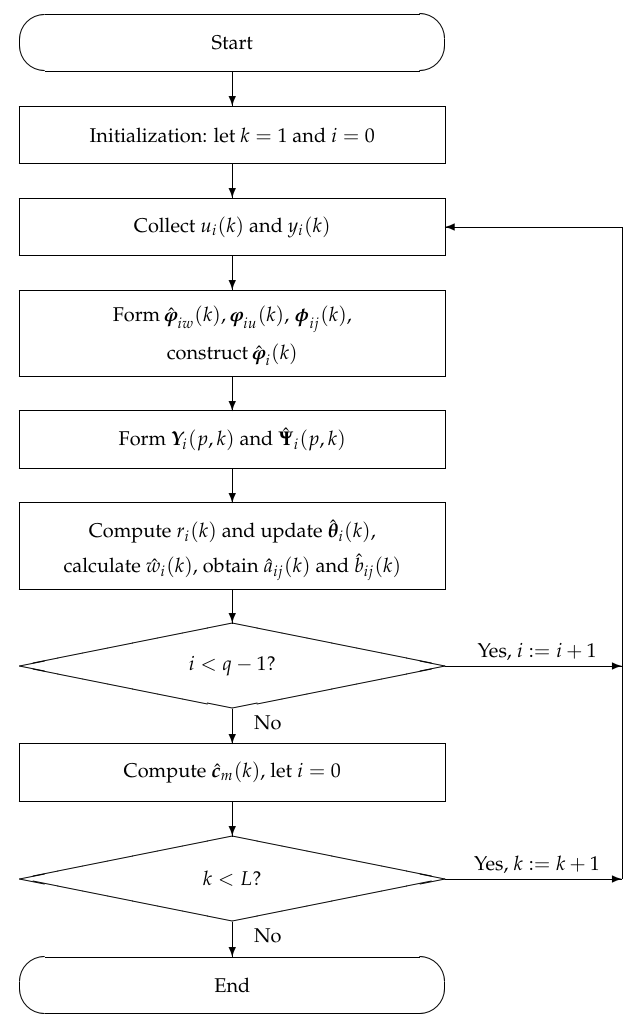
Figure 2. The flowchart of computing the parameter